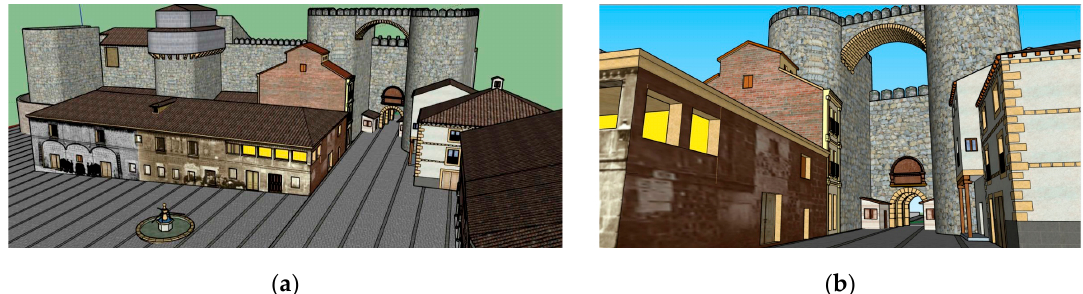
Figure 10. Extramural buildings: ( a ) old photograph texture integration (Laurent, c. 1865, Ruiz Vernacci Archive, VN-17214); ( b ) with 4D modeling for the extramural section of the Alcázar gate. Source: Cultural Heritage Institute of Spain (IPCE). [1].